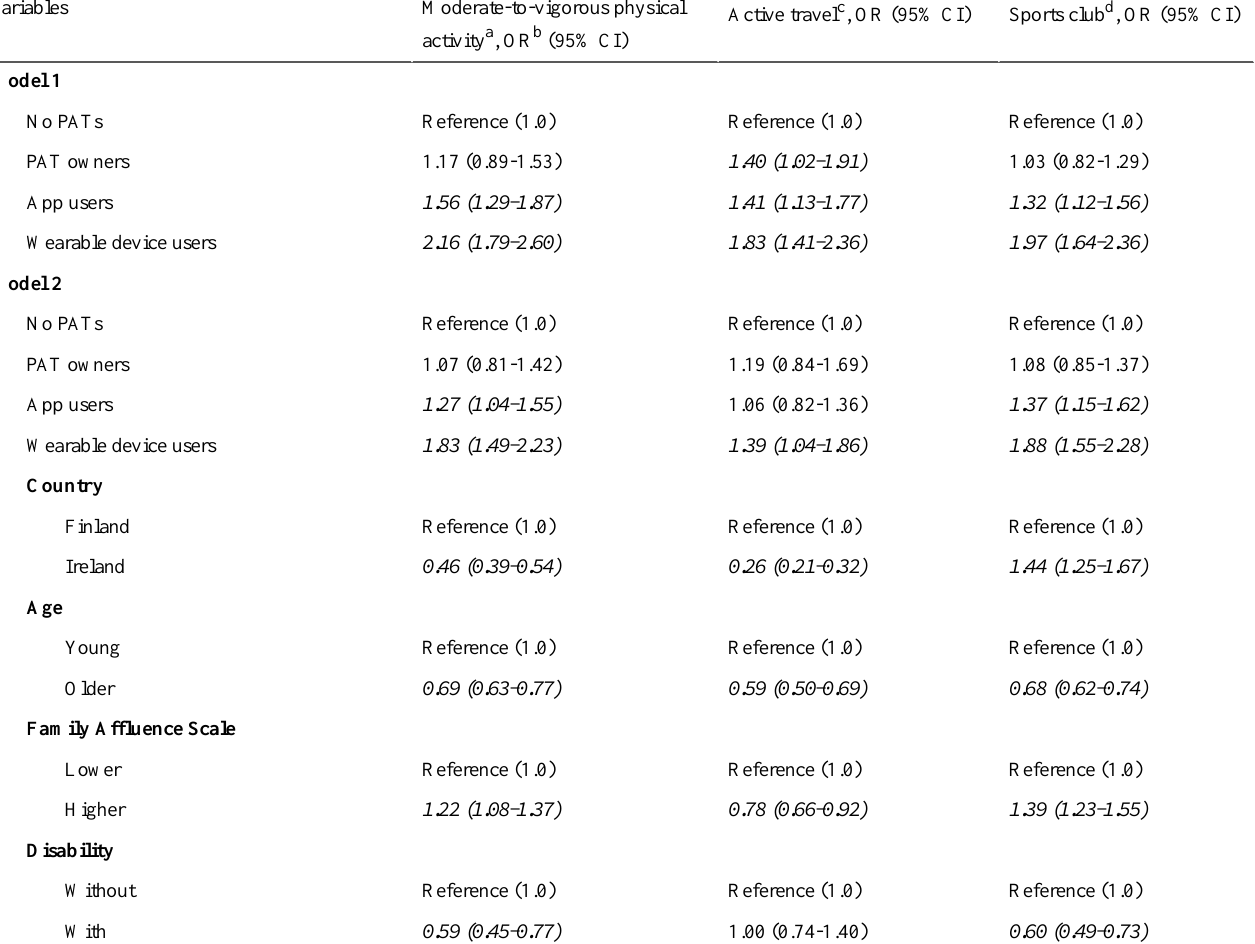
Table 3. Male-adjusted odds ratios and 95% confidence intervals without Model 1 and with Model 2 confounders for each cluster. Italics represents statistically significant